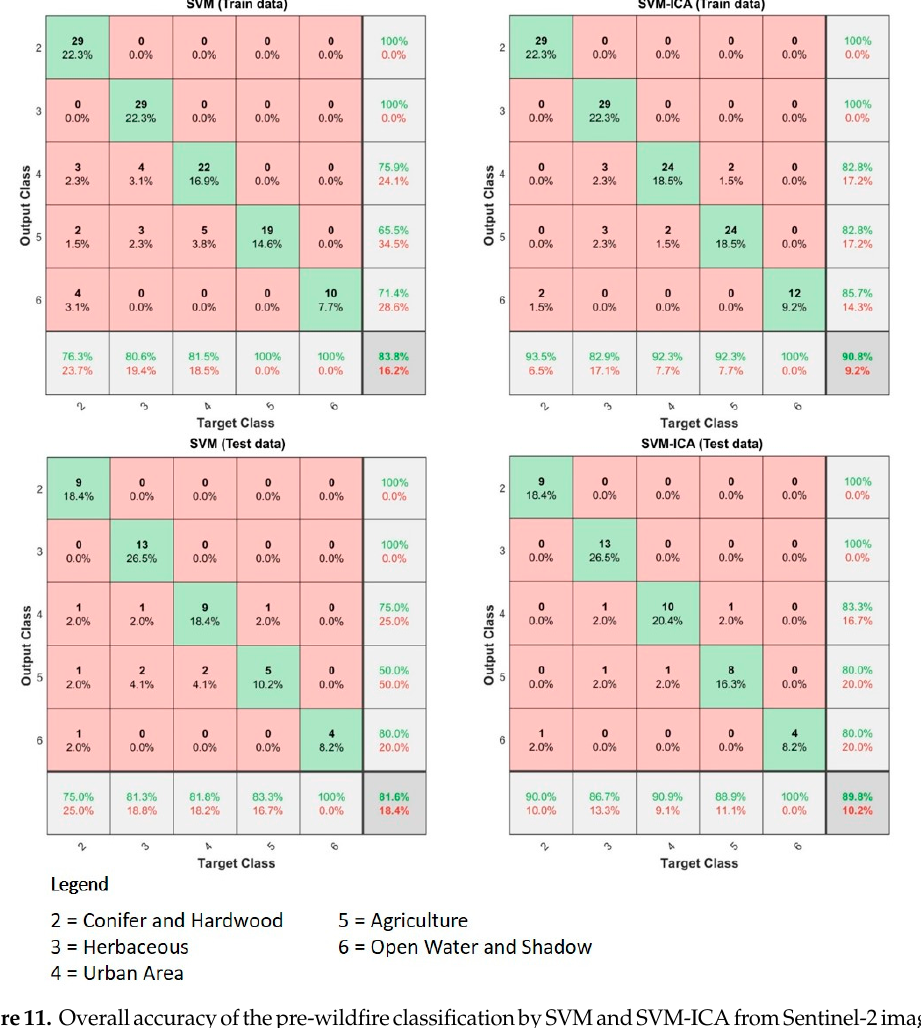
Figure11. Figure 11. Overall accuracy of the pre ‐ wildfire classification by SVM and SVM ‐ ICA from Sentinel ‐ 2 images.